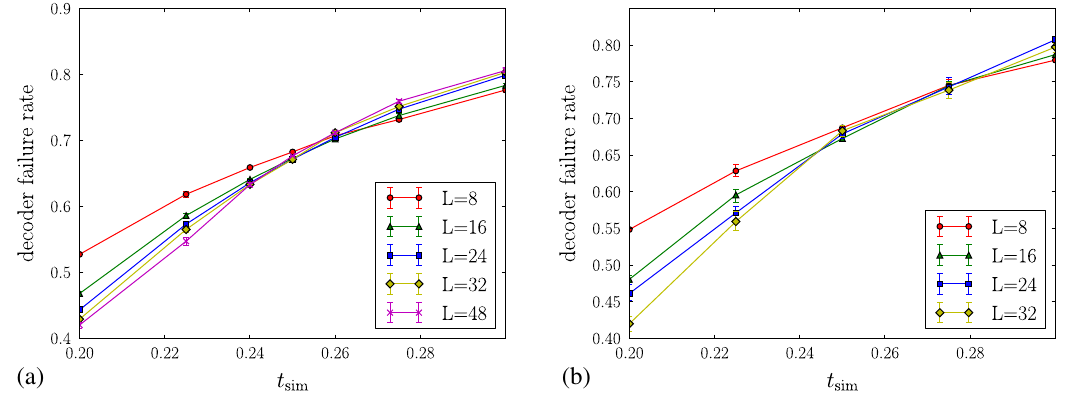
FIG. 5. (a) Logical j 0 i state failure probability versus simulation time (average errors per edge) for γ ψ c ¼ γ σ c using the PMA decoder on the Ising fusion code. (b) Logical jþi state failure probability for the same decoder, code, and noise combination. Both quasi-thresholds are equal to within sampling and finite-size errors.